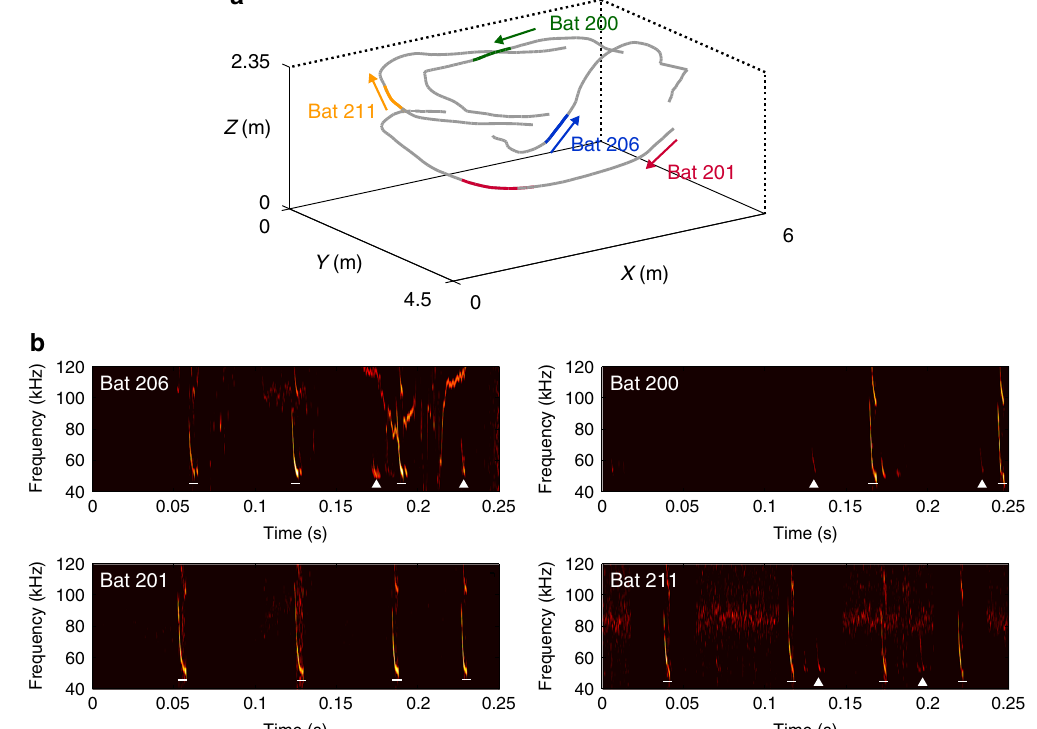
Fig. 1 Echolocation behavior of four bats fl ying together. a Flight trajectories of four simultaneously fl ying bats over a 5-s period. The colors indicate different bats (ID: 206, 201, 200, and 211). The arrows indicate the fl ight directions. b Spectrograms of pulses emitted by four bats during the 250-ms intervals indicated in a as colored lines on the trajectories. White bars indicate self-generated pulses, and white triangles indicate pulses from other